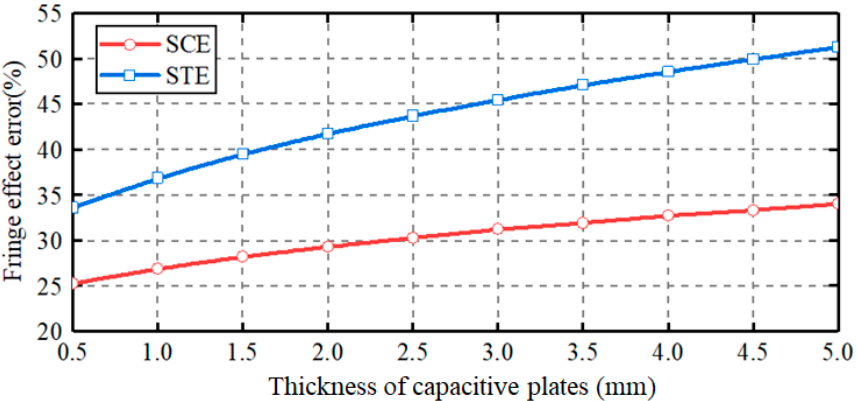
ff ect of plate thickness on the capacitance errors caused by capacitive fringe e ff ect. Figure 9. Effect of plate thickness on the capacitance errors caused by capacitive fringe effect. Figure 9. E